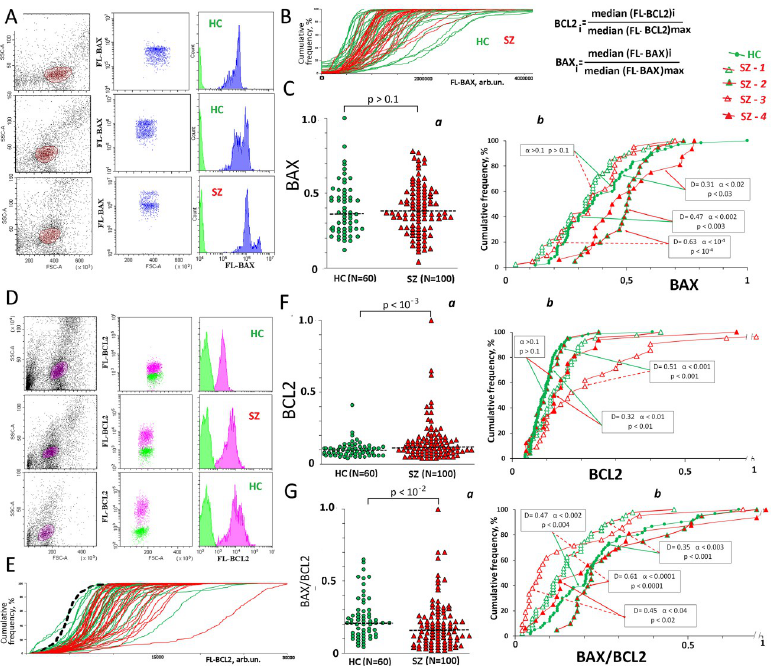
Fig 4. BAX and BCL2 levels in the lymphocyte of the SZ and HC groups. A. The most typical examples of the BAX analysis in lymphocytes. B. Cumulative distribution of FL1- BAX for 80 randomly selected HC (green) and SZ (red) samples in a one experiment. C. BAX levels in the lymphocyte of the SZ and HC groups. (a) The average level of marker in the cell population was estimated by the FL-signal median value. In the graphs, each point is the mean for three FL-signal median values (three parallel measurements for the same PBMC sample). The median values were normalized to the maximum signal medians values in the analyzed total sample (N = 160). The relative standard error was 8 ± 1%. The significance of the observed differences was analyzed using non-parametric Mann–Whitney (p) test. (b) Cumulative distribution of BAX for HC and SZ subgroups. D. The most typical examples of the BCL2 analysis in lymphocytes. E. Cumulative distribution of FL1- BAX for 60 randomly selected HC (green) and SZ (red) samples in a one experiment. The dashed curve is the background curve for the sample with the maximum background level. F. (a) BCL2 levels in the lymphocyte of the SZ and HC groups. The average level of BCL2 in the cell population was estimated by the FL-signal median value. In the graphs, each point is the mean for three FL-signal median values (three parallel measurements for the same PBMC sample). The relative standard error was 4 ± 2%. (b) Cumulative distribution of BCL2 for HC and SZ subgroups. G. (a) Ratio BAX/BCL2 for the SZ and HC groups. (b) Cumulative distribution of BAX/BCL2 for HC and SZ subgroups. Arrows indicate compared subgroups. The significance of the observed differences was analyzed using the non-parametric Mann–Whitney test (p) and Kolmogorov–Smirnov test (D and α